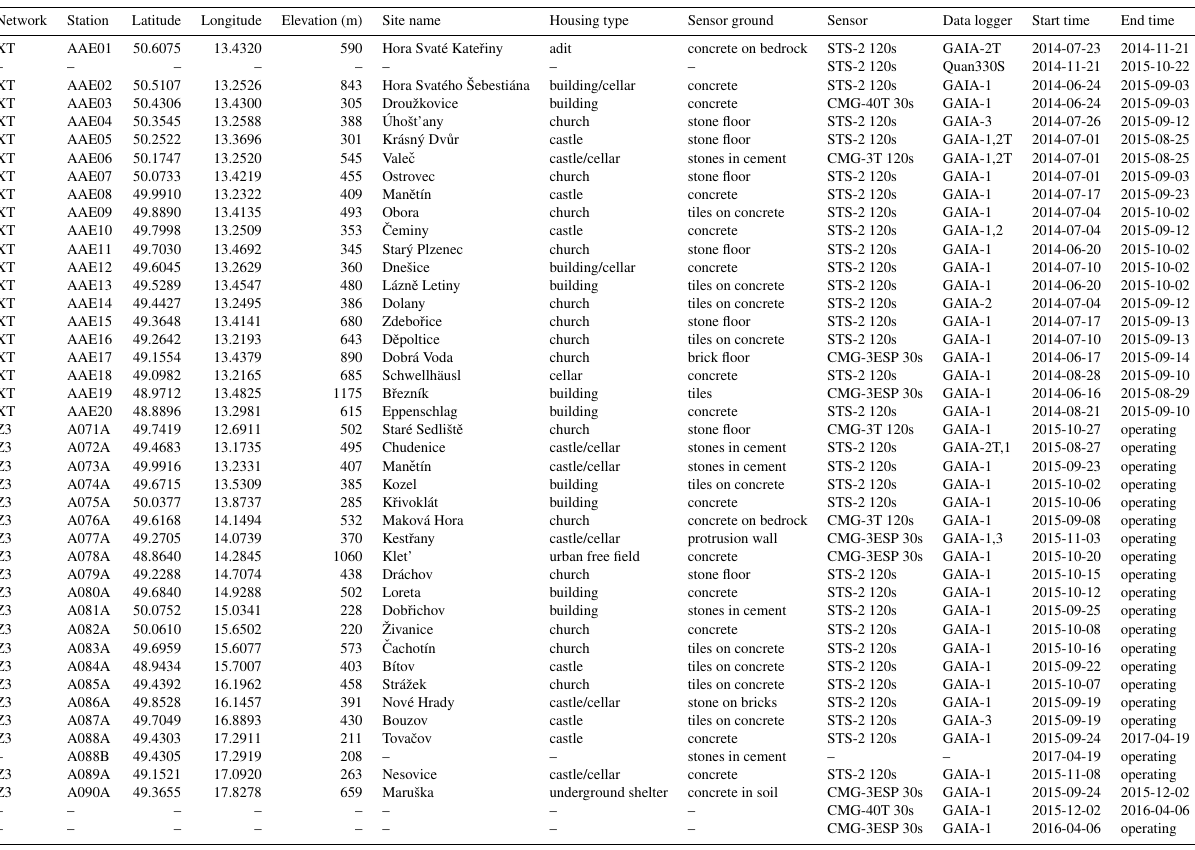
Table 1. List of Czech temporary stations from the MOBNET pool involved in the AlpArray-EASI complementary experiment (network code XT) and the AlpArray Seismic Network (AASN, network code